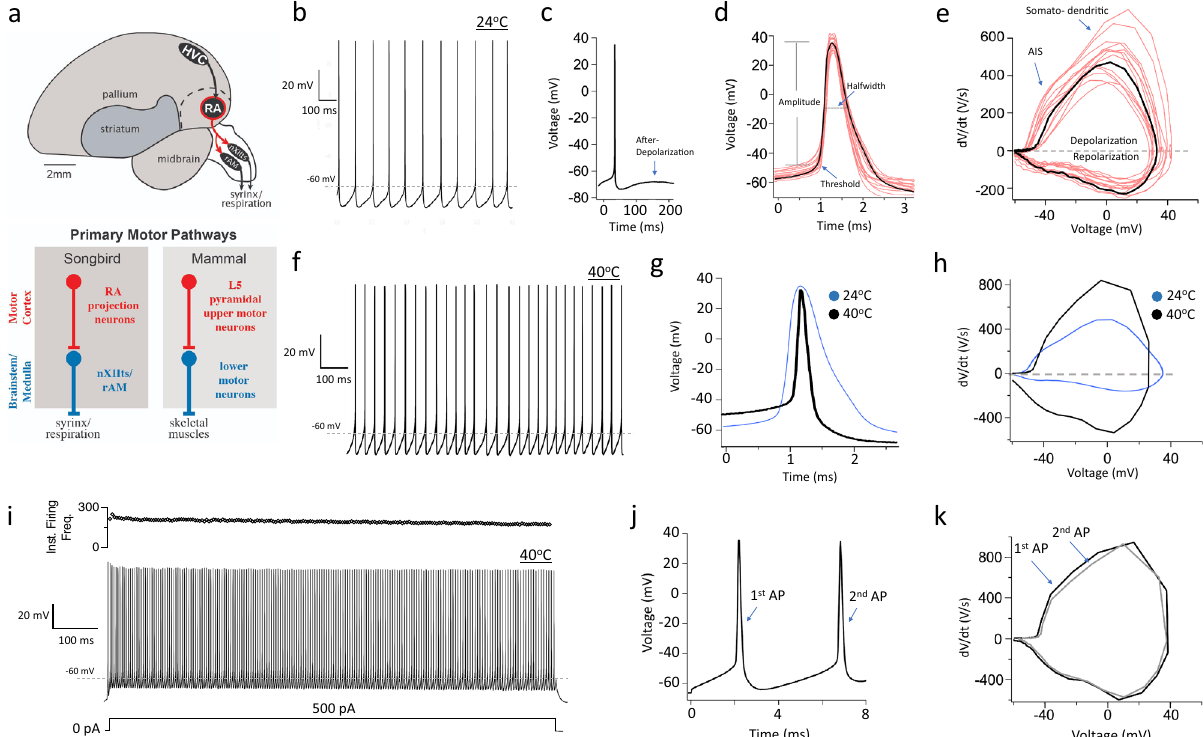
Fig. 1 Ultra-narrow spikes and high frequency fi ring in RA projection neurons (RAPNs) of adult male zebra fi nches. a Hyperdirect motor pathways in songbirds and mammals. Top: Zebra fi nch vocal control circuitry; nuclei and connections of the direct vocal-motor pathway shown in black, RA and its descending projections highlighted in red, other nuclei and connections omitted for clarity. The dashed line represents the dorsal boundary of the arcopallium. HVC is a proper name; RA, robust nucleus of the arcopallium; nXIIts, tracheosyringeal division of the hypoglossal nerve nucleus; RAm, nucleus retroambigualis medialis. Bottom: Diagram depicting upper (red) and lower (blue) motor neurons of the descending motor pathway in zebra fi nch, a songbird (left), and mammals (right). b Whole-cell current-clamp recording of spontaneous APs during 1 s at room temperature (24 °C). c Spontaneous AP from a different cell (same bird) than ( b ), arrow indicates after-depolarization. d Representative spontaneous AP from ( b ; black) with an overlay of spontaneous APs from an additional 15 RAPNs (pink); values for the indicated parameters are presented in Table 1. Data were obtained from multiple RAPNs from 6 adult male birds. e Phase plane plots of the AP in ( d ; black) and from another 15 RAPNs (pink, same cells as in d ); indicated are the presumed contributions of the axonal initial segment (AIS) and somatodendritic components to the biphasic depolarization component in the phase plane plot. f Whole-cell current-clamp recording of spontaneous APs during 1 s in a RAPN at physiological temperature (40 °C). g Representative spontaneous AP recorded at physiological temperature (40 °C; black) with an overlay of a spontaneous AP recorded at room temperature (24 °C; blue). Recordings were taken from different birds in separate experiments. h Overlayed phase plane plots of the spontaneous APs from panel ( g ). i Representative AP train elicited by a 1 s 500 pA current injection at 40 °C; the corresponding plot of instantaneous fi ring frequency (Inst. Firing Freq.; in Hz) as a function of time is shown at the top. j First two APs from ( i ). k Overlay of the phase plane plots from the two APs in ( j ). The spike trains exhibit almost no